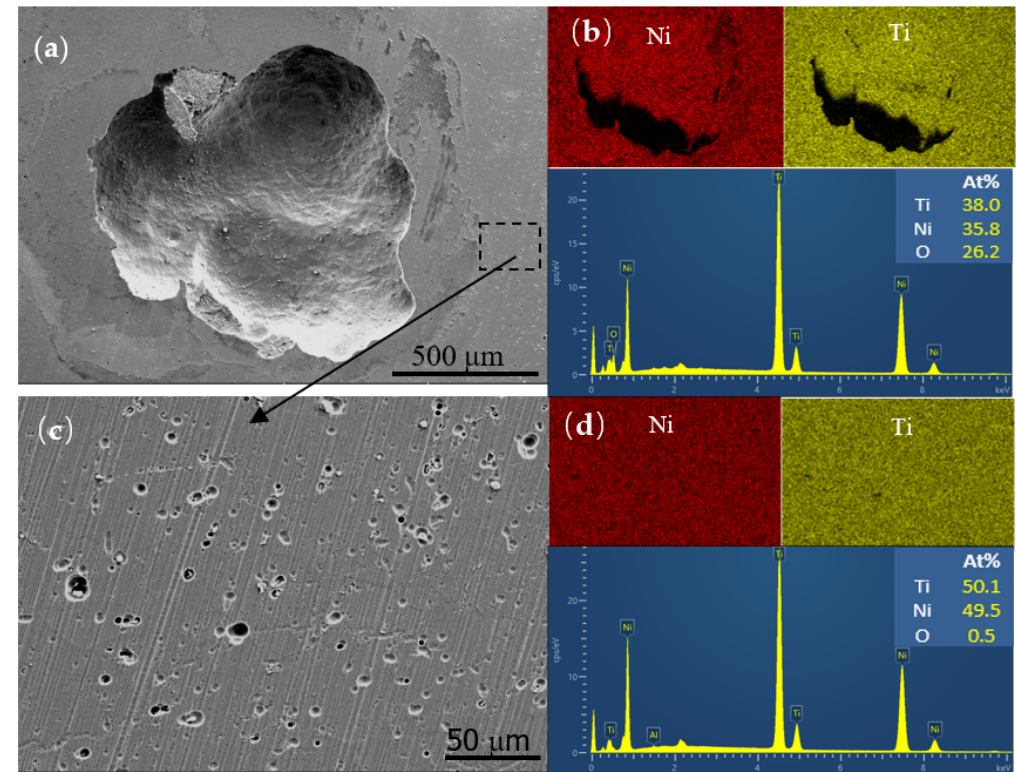
Figure 11. SEM and EDS images of wrought TiNi sample after corrosion in 0.5% F − ASS at pH 4. ( a ) is SEM image of a large corrosion pit; ( b ) is EDS results and element distribution for the whole area shown in ( a ); ( c ) is enlarged images in the vicinity of the large corrosion pit circled in ( a ); ( d ) is EDS results and element distribution for the whole area shown in ( c ).